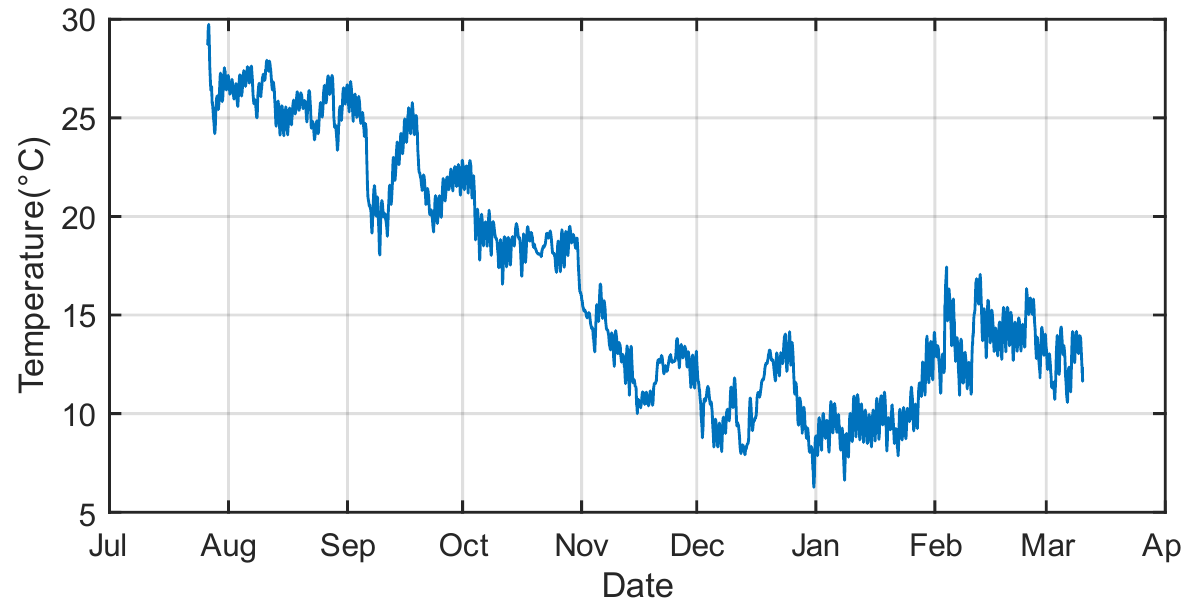
Figure 2. Temperature ( ◦ C) of the mesocosms during the test. The monitoring of the electrical conductivity is shown in Figure 3. As the electrical conductivity is affected by the temperature variation, the trend of the temperature follows a different trend for the electrical conductivity. A gradual decrease in temperature from August up to December is observed. Meanwhile, the electrical conductivity of the biostim- ulated mesocosms (BS and BS + IN) showed a marked decrease at the very early stage of the experiment (first weeks). This proves the relatively negligible effect of the temperature on the behaviour of electrical conductivity.